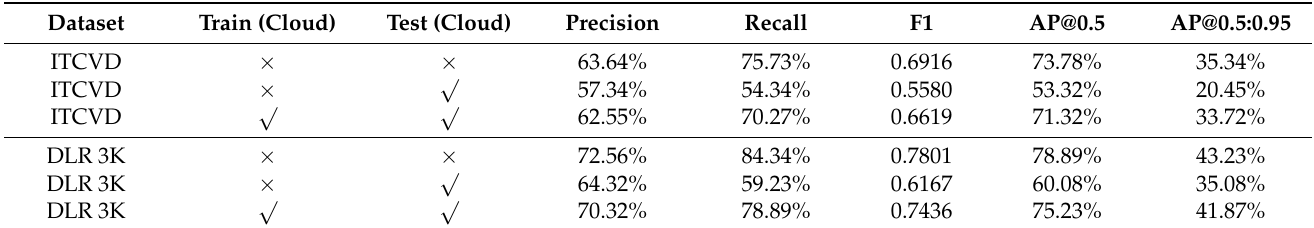
Table 4. Cloud simulation performance